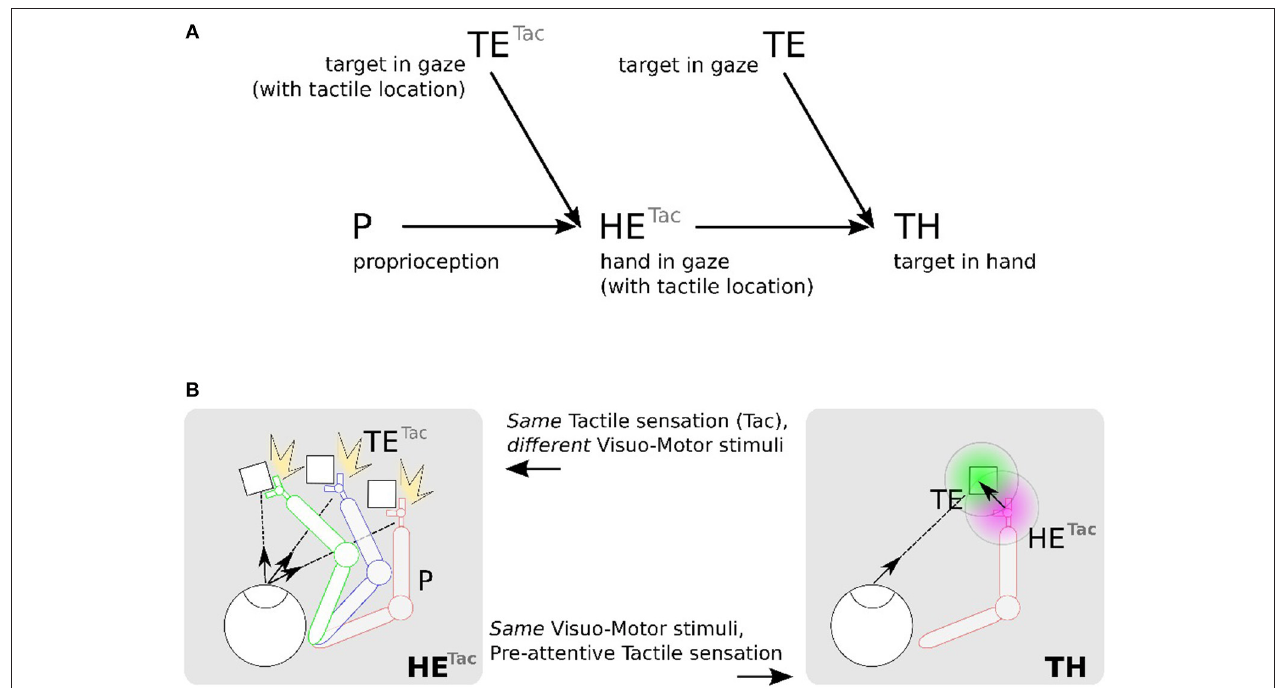
FIGURE 4 | Proposed mechanism for constructing a hand-centered represention from multimodal infomation. (A) We can construct in a hand-centered reference frame (TH) by merging the hand location (HE) and target location in the eye-centered visual space (TE). Locating the hand in the visual space (HE) can be done by binding the location of seen targets (TE) and the proprioceptive information of the arm posture (P) conditionally to the perceived tactile sensation Tac . (B) . TE Tac and HE Tac can be constructed from multiple associations between visuomotor pairs only when a contact occurs (left). From the predicted location of the hand from HE Tac , it possible then to estimate visually the distance and orientation to the hand